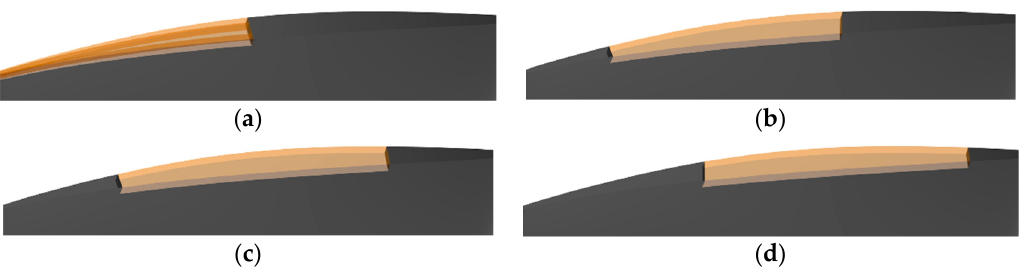
Figure 2. Partial clearance schemes for ( a ): Case 1, ( b ): Case 2, ( c ): Case 3, and ( d ) Case 4. Table 2. Clearance parameters in di ff erent cases.